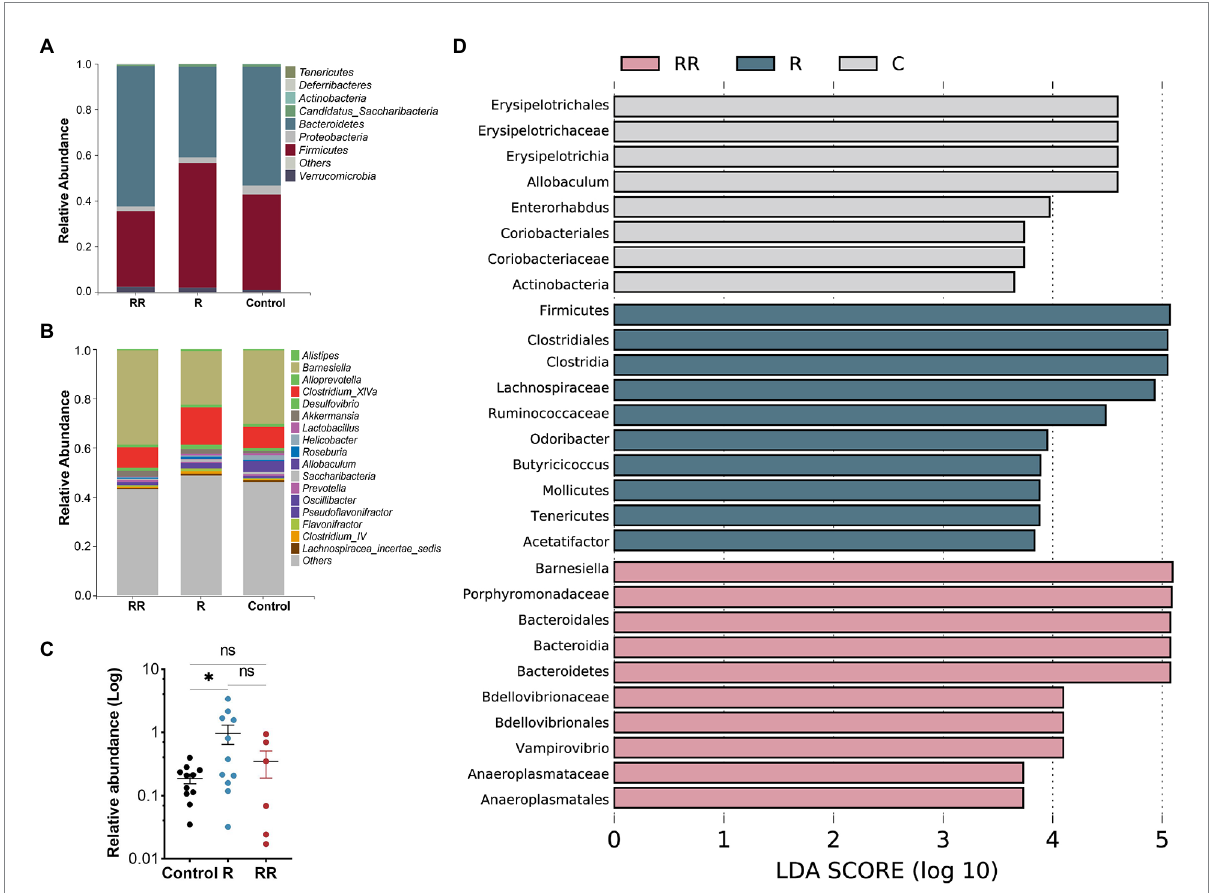
FIGURE 7 Classification of microflora at the phylum (A) , and genus (B) levels. (C) Relative abundance of Roseburia intestinalis among different groups. R: 7 days group; RR: 14 days group. (D) LEfSe analysis between different groups, displaying only genera with absolute values of linear discriminant analysis (LDA) scores greater than 2.0. * indicates p < 0.05, ns indicates no